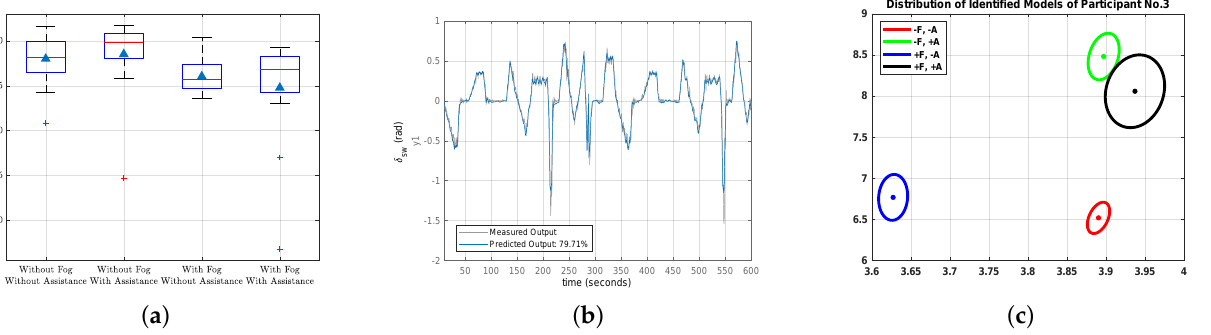
Figure 9. Identified model validation: ( a ) FIT for all participants; ( b ) measured vs. predicted steering- wheel angle for Participant No. 1 in the First Scenario; ( c ) confidence regions of identified parameters for Participant No. 3.